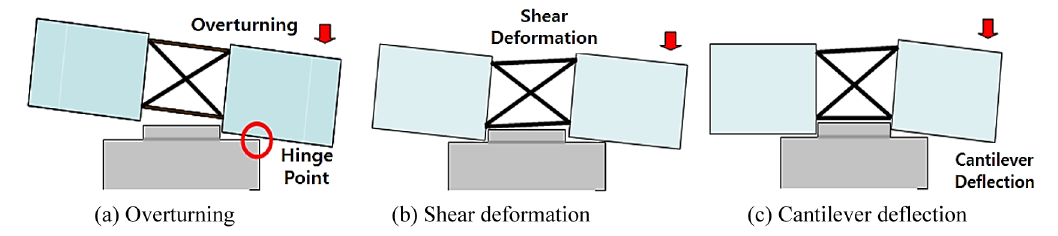
Fig. 9. Types of deformation of GG2 while eccentric